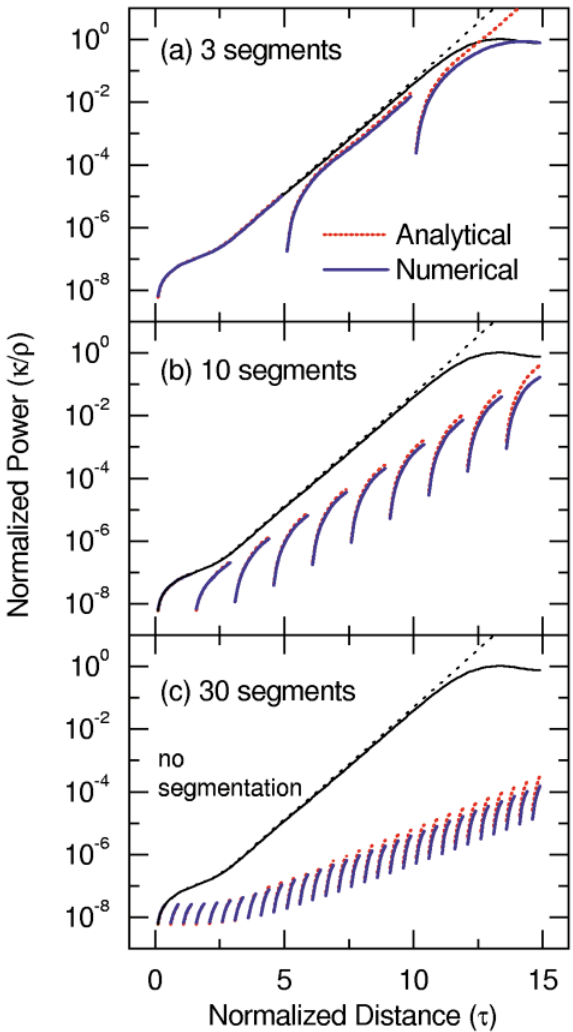
FIG. 3. (Color) Same as Fig. 2, but for the phase-flip case. dissipated to accelerate the electrons. In all cases of seg- mentation, the efficiency does not saturate before the end of the undulator; however it should be noted that amplifica- tion occurs in spite of the antiresonance condition. We can find the reason in Fig. 4 where the spectrum of the ampli- fied radiation, or the dependence of j E v j 2 on D k u (cid:1)(cid:2) 2 r k u (cid:3) , is plotted for different values of t . The spectrum is nor- malized so that the power obtained by integration over D k u is equal to unity. In the case of no segmentation, the radia- tion around the resonance energy (cid:2) D k u (cid:1) 0 (cid:3) is amplified. On the other hand, no amplification takes place at the res- onance energy in the case of 30 segments because of the antiresonance condition, while there are two different en- ergies where amplification occurs. However, such a peak split is in general undesirable for the user of the FEL. In any case, the number of segments should be as small as possible to obtain high